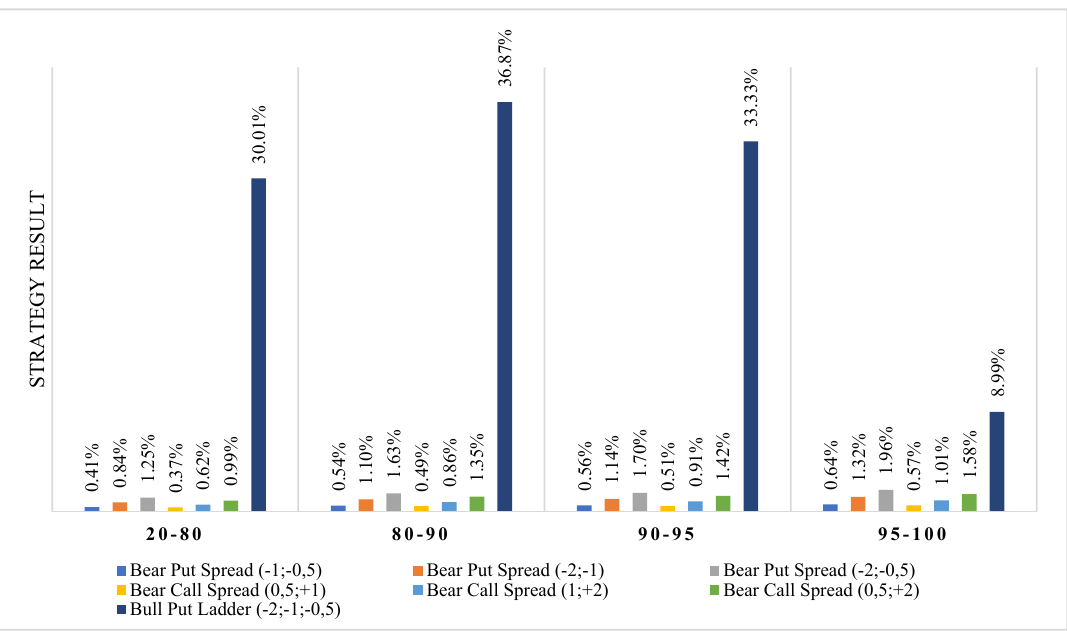
Figure 6. Bear put spread, bear call spread, and bull put ladder results for declines of WTI oil prices exceeding 20%.